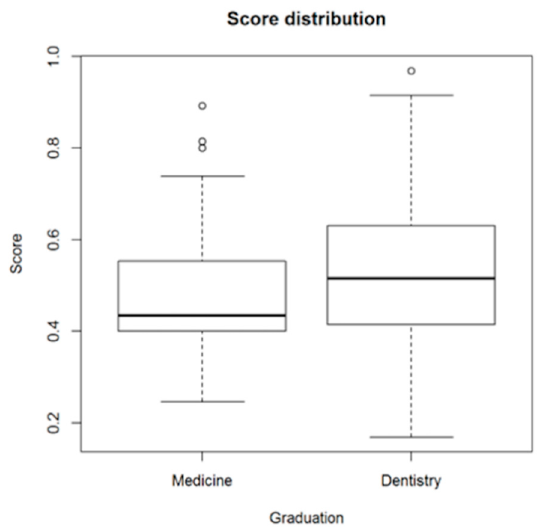
Figure 2. Distribution of average scores among dentists with medicine and dentistry degrees.